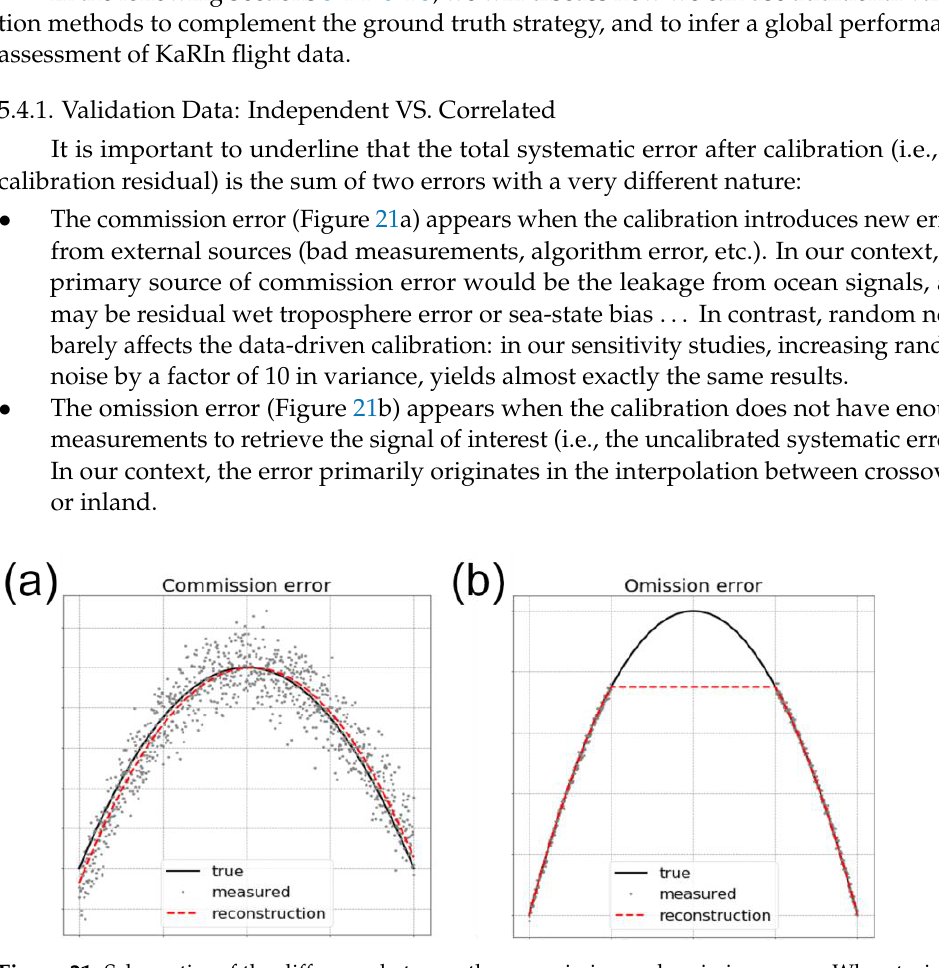
Figure 21. Schematics of the difference between the commission and omission errors. When trying to retrieve the true signal (black line) with measured data (grey points), the reconstruction (red line) is not aligned with the truth. In panel ( a ), the error primarily originates in the absorption (or leakage) of the random measurement noise which slightly skews the estimated value in red: this is a commission error due to imperfect measurements of the signal of interest. In panel ( b ), the error originates in a large data gap in the middle of the scene: this is an omission error due to a lack of measurement.